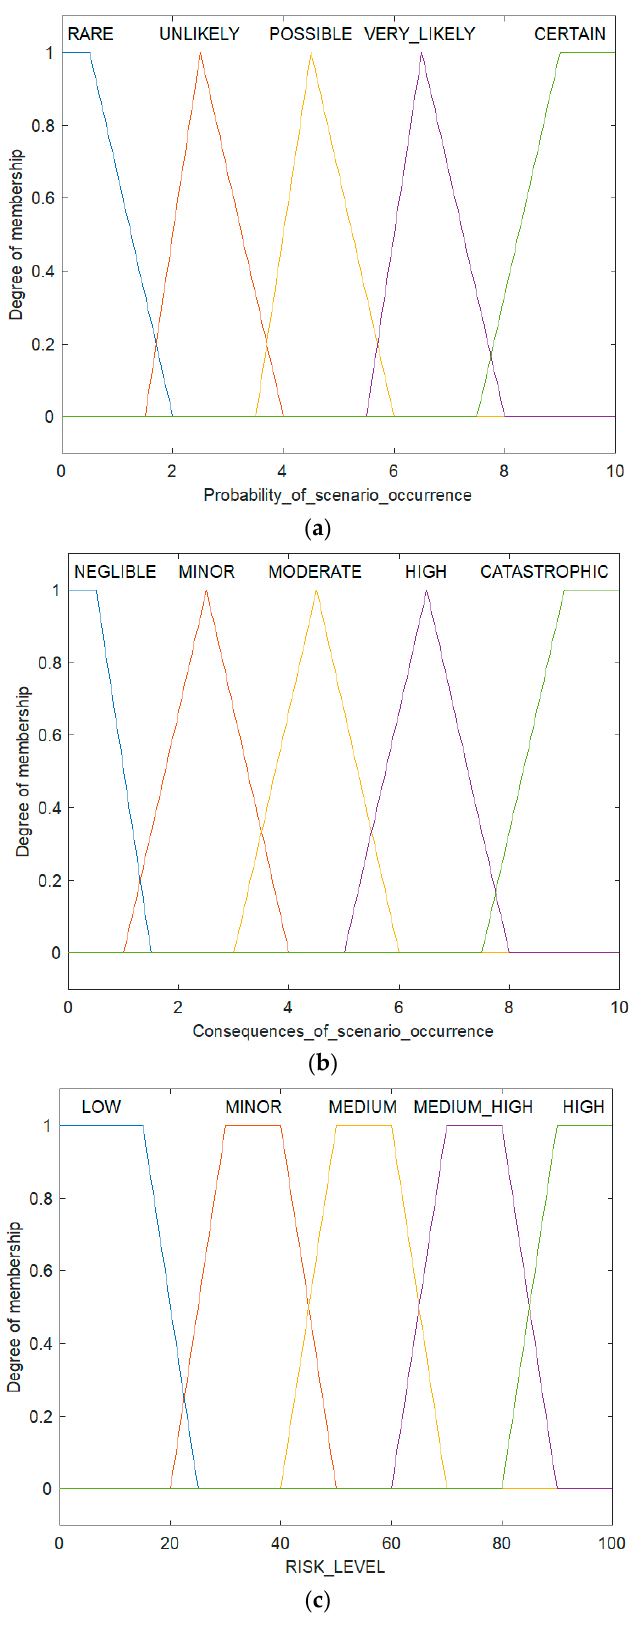
Figure 7. Membership functions: ( a ) probability of the scenario occurrence; ( b ) consequences of the scenario occurrence; ( c ) risk